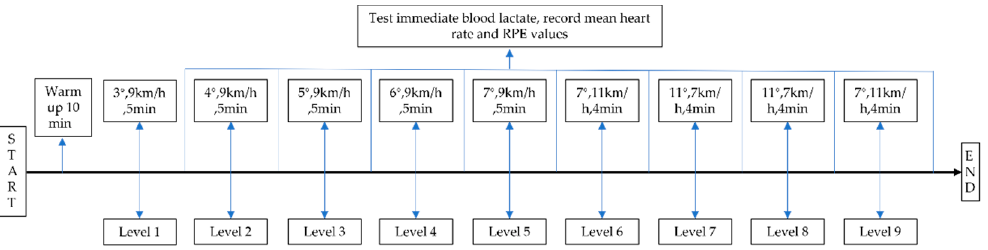
Figure 1. Flow chart of treadmill roller-skiing tests.